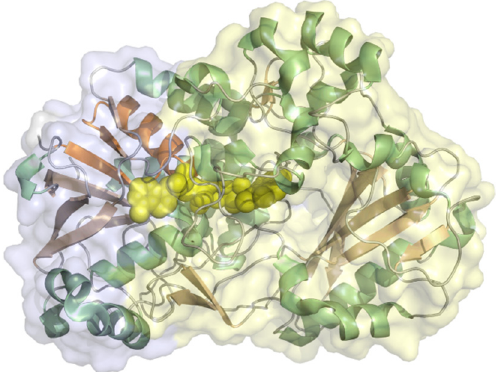
Figure 6. Crystal structure of the dehydrogenase domain of Neurospora crassa cellobiose dehydro- genase (PDB: 4QI7) with the FAD cofactor (yellow spheres) buried inside the protein shell. The FAD-binding and substrate-binding subunits are colored light blue and light yellow, respectively. The GMC-oxidoreductase family characteristic dinucleotide binding βαβ -motif (Rossmann-fold) is highlighted in